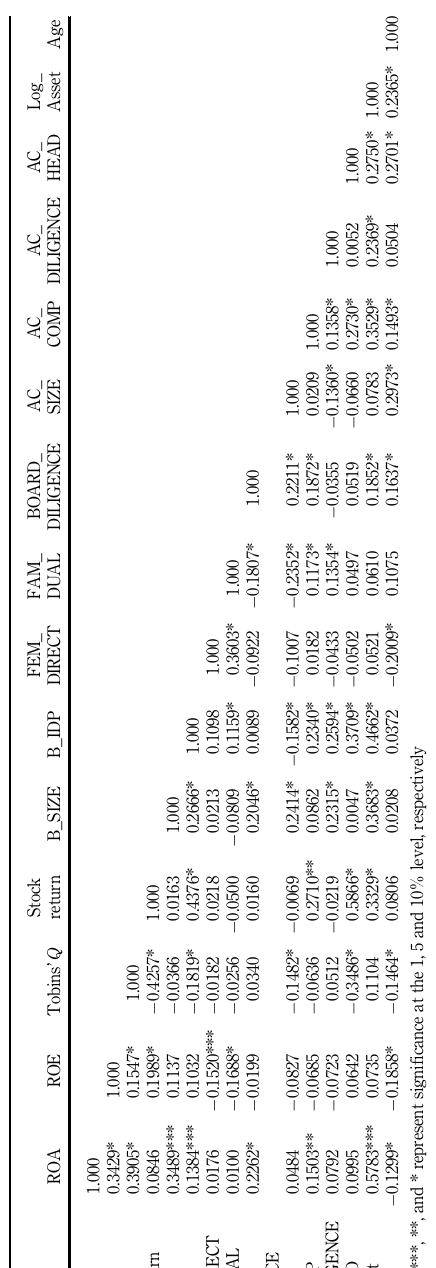
Table 2. Correlation